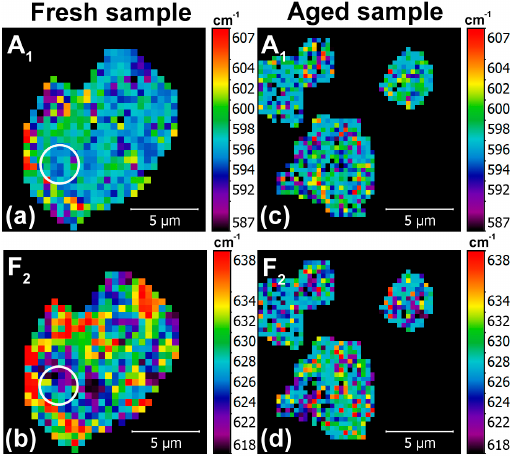
Figure 4. Mapping of the ( a , c ) A 1 and ( b , d ) F 2 peak positions in the active ionic particles of ( a , b ) fresh and ( c , d ) aged LMO cathodes. Delithiated state: Li 0.6 Mn 2 O 4 (100% SOC).